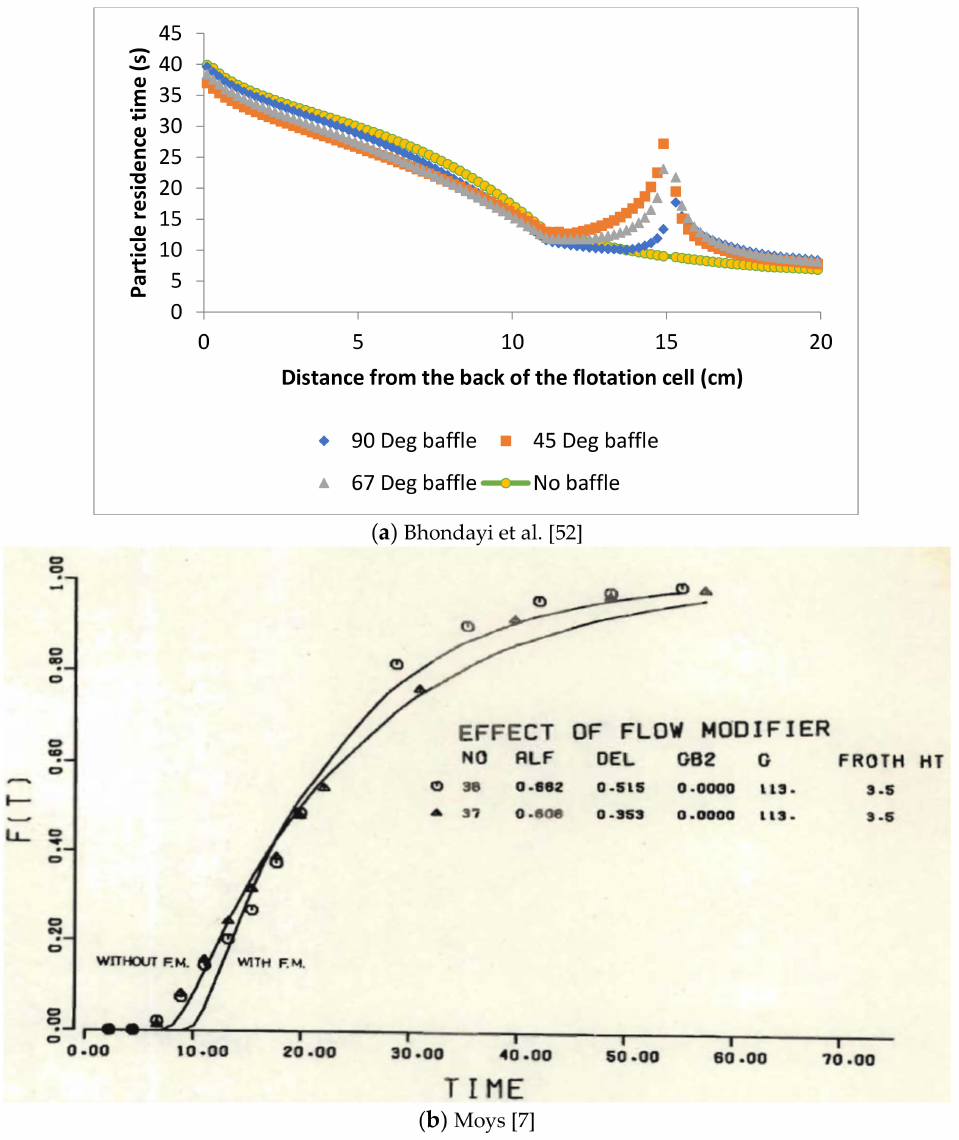
Figure 21. Impact of a froth baffle on froth residence time distribution as a function of distance from the back of the flotation cell: ( a ) Bhondayi et al. [52]; ( b ) Moys